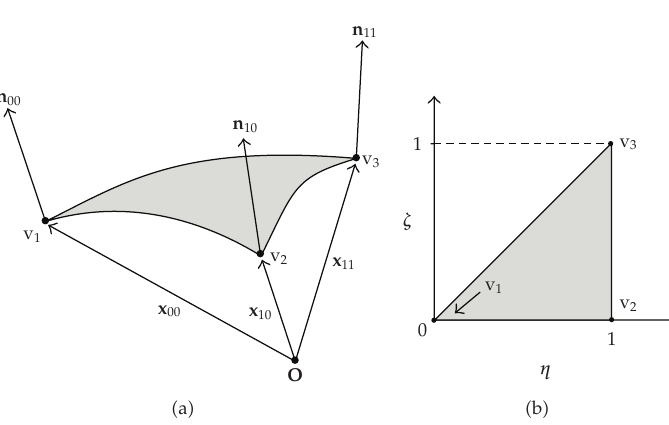
Figure 2: Interpolation of a triangular patch using the normals at its